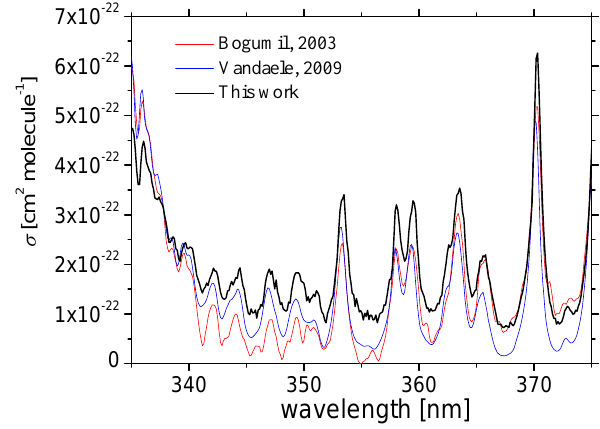
Fig. 4. SO 2 absorption cross-sections spectra from this work Figure 4. SO 2 absorption cross-sections spectra from this work (black), Bogumil (red) 2 (black), Bogumil (red) and Vandaele (blue). The literature spectra and Vandaele (blue). The literature spectra were convoluted to our spectrograph resolution. 3 were convoluted to our spectrograph resolution.